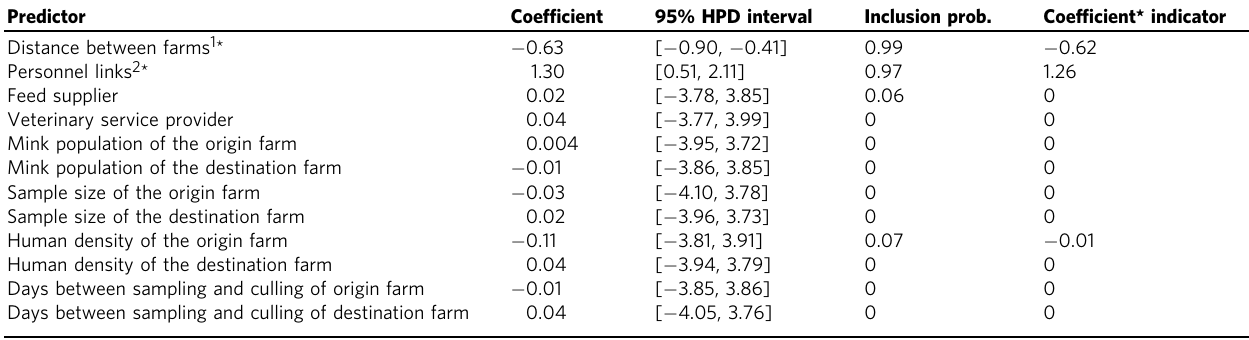
Table 1 The contribution of predictors of SARS-CoV-2 (Cluster A) transmissions between mink farms.